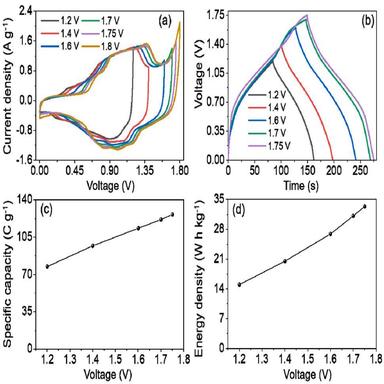
(a) The CV curves of MnCo2O4.5 NSs//AC HSC over different voltage windows at a scan rate of 10 mV s − 1 , (b) the GCD curves of MnCo2O4.5 NSs//AC HSC over different voltage windows at 1 A g− 1 , (c) the relationship of specific capacity vs. voltage window for MnCo2O4.5 NSs//AC HSC, and (d) the plot of energy density as a function of voltage window for MnCo2O4.5 NSs//AC HSC.